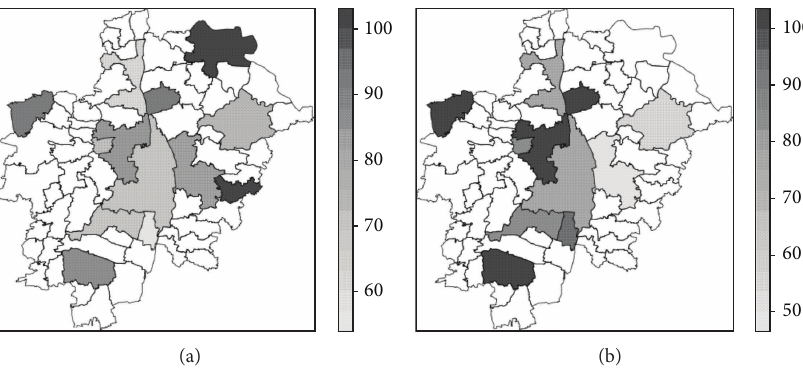
Figure 5: Spatial distribution of samples according to land of birth. (a) Spatial distribution of GER P; (b) spatial distribution of MAIN IMP.